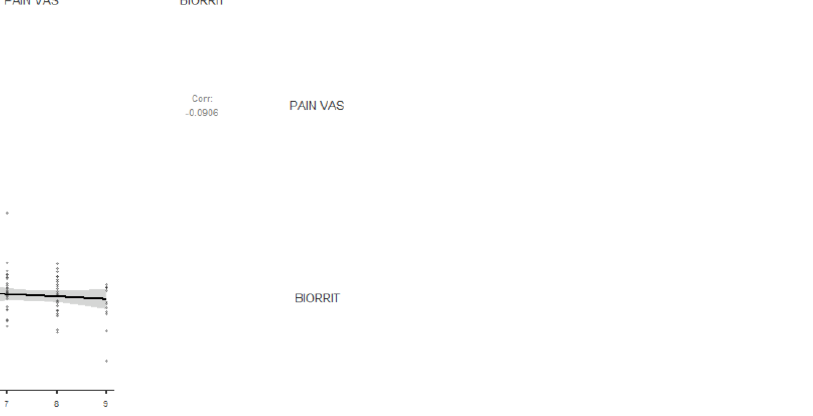
Figure 2. Scatter plot showing the association between BPI and pain (VAS) within the